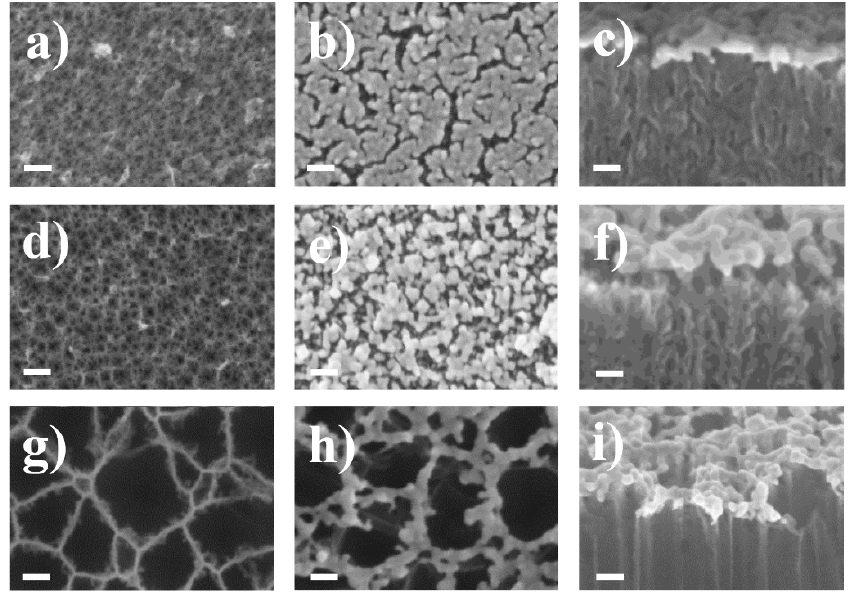
Figure 1. SEM planar and cross-section images of PSi films before ( a , d , g ) and after gold nanoparticle (Au NP) deposition ( b , c , e , f , h , i ): ( a ) PSi-1; ( b ) and ( c ) Au/PSi-1; ( d ) PSi-2; ( e ) and ( f ) Au/PSi-2; ( g ) PSi- 3; ( h ) and ( i ) Au/PSi-3. Scale bar in all images is 50